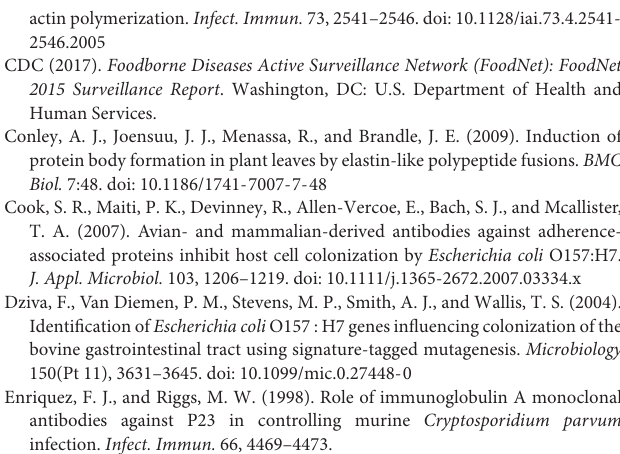
FIGURE S1 | Validation of recombinant maltose-binding protein (MBP)-EHEC O157:H7 intimin fusion protein. (A) Amino acid sequence of MBP-Int277 fusion protein. MBP sequence is underlined and TEV protease cleavage site is shown in blue. The fusion protein had a molecular mass of 73,781 Da and a theoretical pI of 6.06. (B) SDS-PAGE (4–20% gradient) stained with Coomassie Brilliant Blue. Lane 1, BSA; Lane 2, MBP-Int277. (C) Western blot of MBP-Int277 using either anti-6 × His antibody (Lane 3) or anti-MBP antibody (Lane 4). (D) Size exclusion profile of MBP-Int277 on a Superdex TM 75 10/300 GL column showing monodisperse behavior. (E) Binding of polyclonal goat anti-intimin antibody to MBP-Int277 in ELISA and detected with HRP-conjugated donkey anti-goat IgG. FIGURE S2 | Sequences for Int277 are similar across EHEC strains O157, O111, O26, and O145. (A) Multiple sequence alignment using Clustal Omega default settings of Int277 protein sequence for the seven tested EHEC strains. The alignment has been shaded to show identical residues in black and similar residues in gray. (B) Phylogenetic tree using a neighbor joining method to cluster the aligned Int277 sequences based on similarity. The cladogram shown has not been corrected for evolutionary distance and is merely meant to be representative of how the strains cluster based on